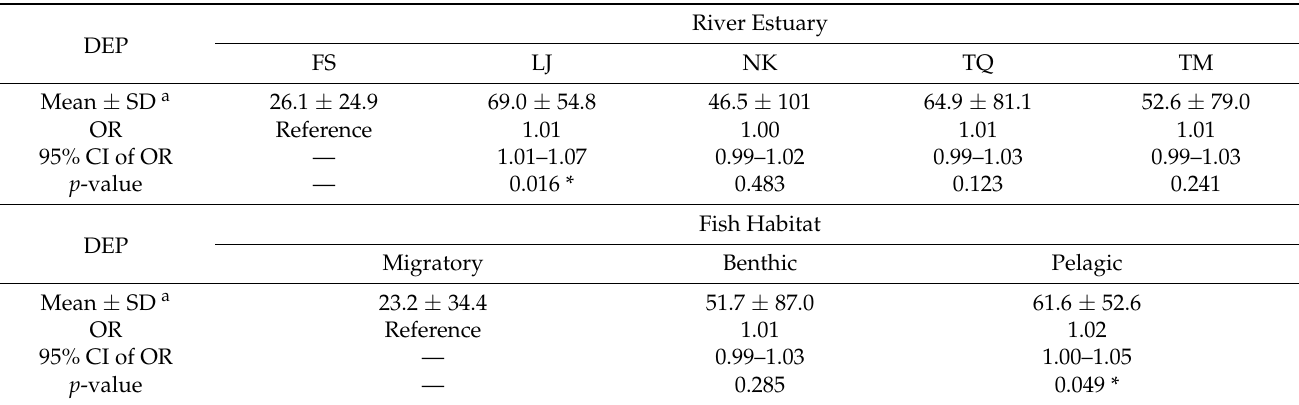
Table 5. The chemicals of EEDCs were used to predict MPs by simple stepwise linear regression models. Dependence EDCs